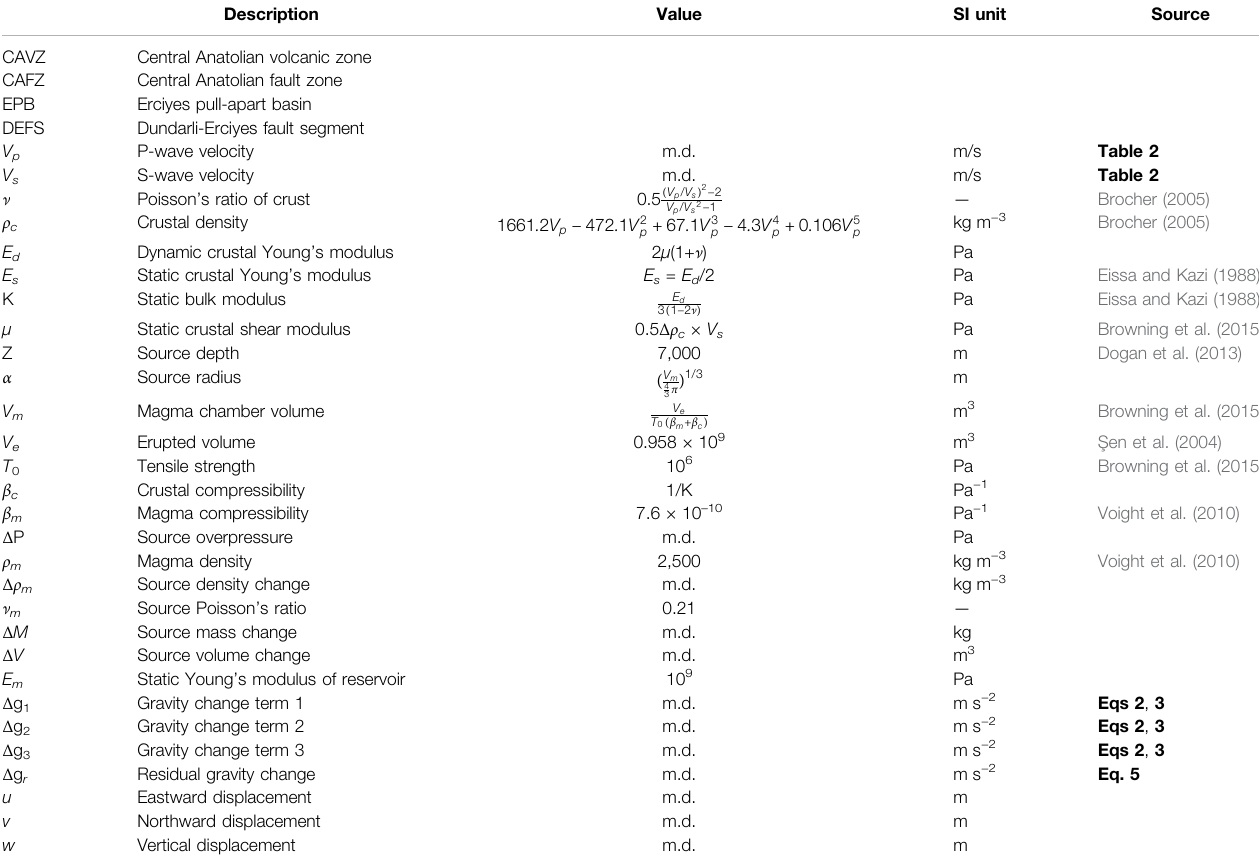
TABLE 1 | Model parameters, symbols and abbreviations used in this